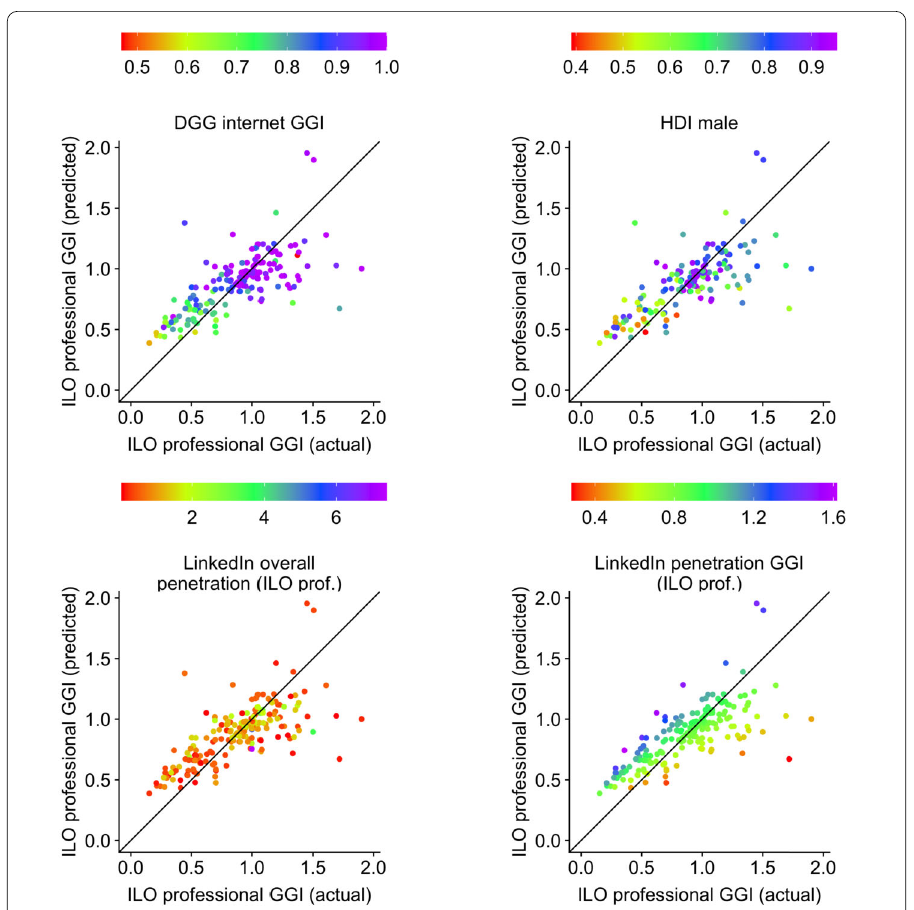
Figure 7 Scatter plot of ILO professional GGI (actual) ( x -axis) and ILO professional GGI (predicted) ( y -axis). Points in each panel are colour coded by values of the variable listed